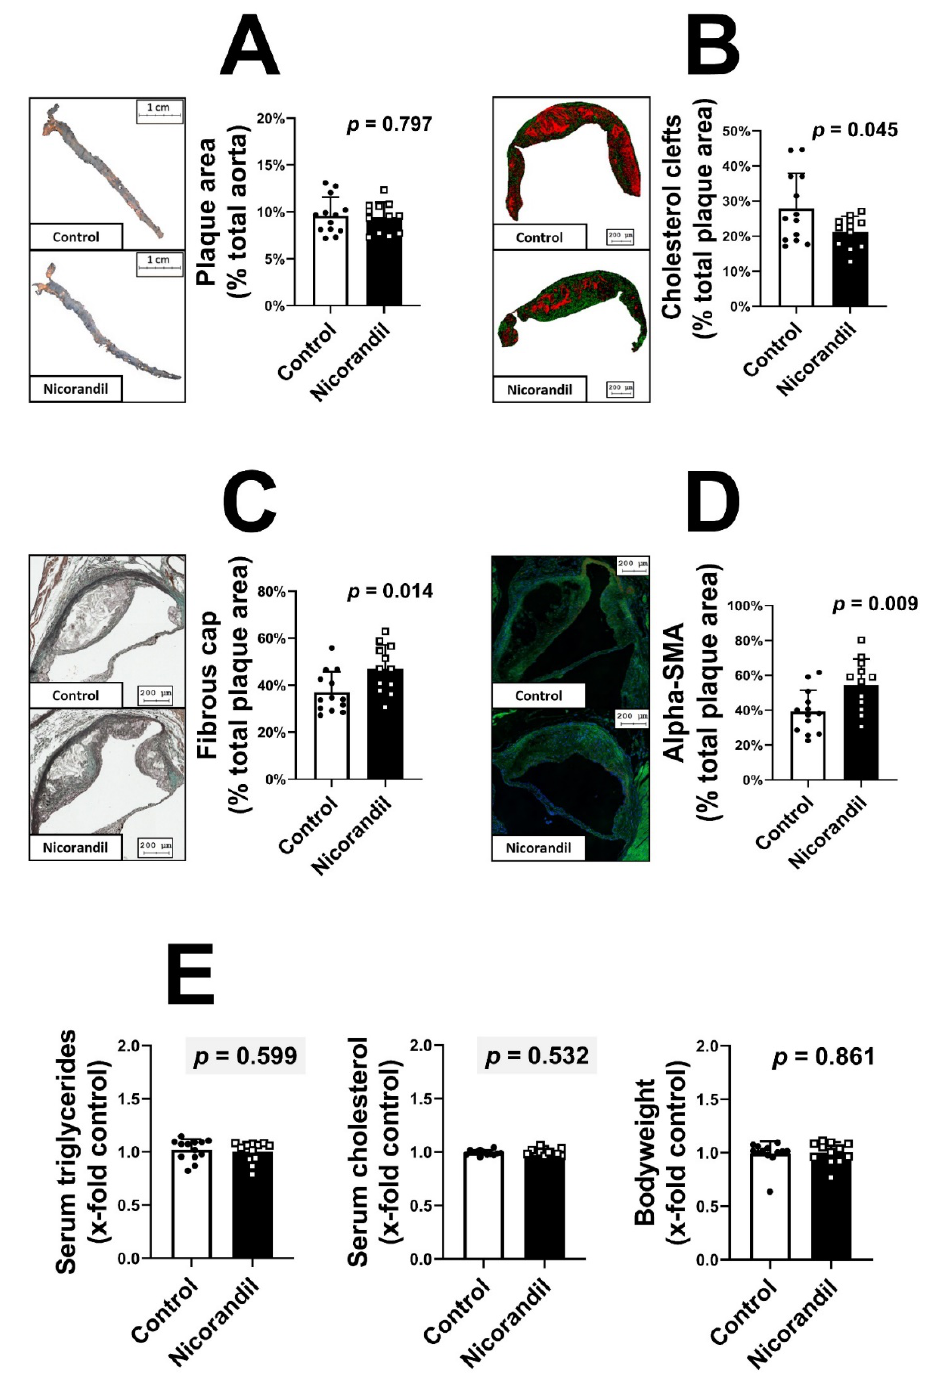
Figure 1. Atherosclerotic plaque development after nicorandil treatment. Atherosclerotic plaque formation was induced by a high-fat diet in 25 LDL-R -/- mice. The animals were randomized to either a control group ( n = 13) or a nicorandil treatment group ( n = 12, 10 mg/kg/day). No difference in plaque size was observable between the groups, as determined by en face staining ( A ). Nicorandil treatment led to a significant reduction in cholesterol clefts. Images show software analysis of TissueFAXS scans of Mason Trichrome staining in a false color format ( B ). In addition, nicorandil treatment led to a significant increased thickness of the fibrous cap ( C ) and an increased smooth muscle cell content ( D ). No difference in serum triglyceride levels, cholesterol levels, and body weight ( E ) was observed at time of sacrifice. All values given represent means ± standard deviations; the statistical significance of p ≤ 0.05 was considered significant.